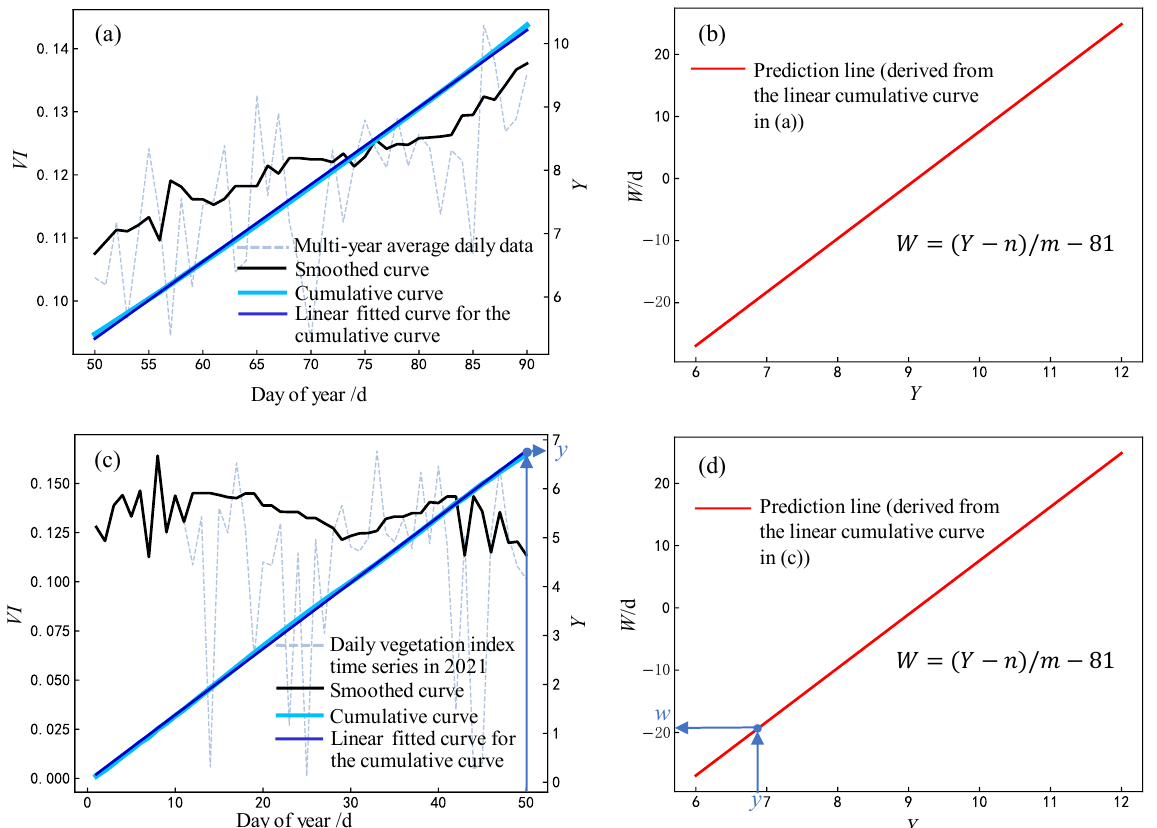
Figure 3. An example shows how the prediction model of pollen allergy works for each year. ( a ) The preprocess of vegetation index data during 2011–2021; ( b ) the final cumulative linear fit prediction model; ( c ) the preprocess of vegetation index data in 2021 from the 1st day to the 50th day; and ( d ) the process of predicting pollen allergy in 2021. Y is the vegetation index value; W is the predicted number of days to the outbreak date of spring pollen allergy in Beijing (a negative value indicates that the outbreak date has not yet arrived, and a positive value indicates that the outbreak date has passed); y is the smoothed cumulative vegetation index value on the 50th day in 2021; and w is the predicted number of days to the outbreak date of spring pollen allergy in Beijing in 2021. Note the difference between the model building with the multi-year average vegetation index time series in ( a ) and the model prediction with the daily vegetation index time series in a certain year in ( c ).